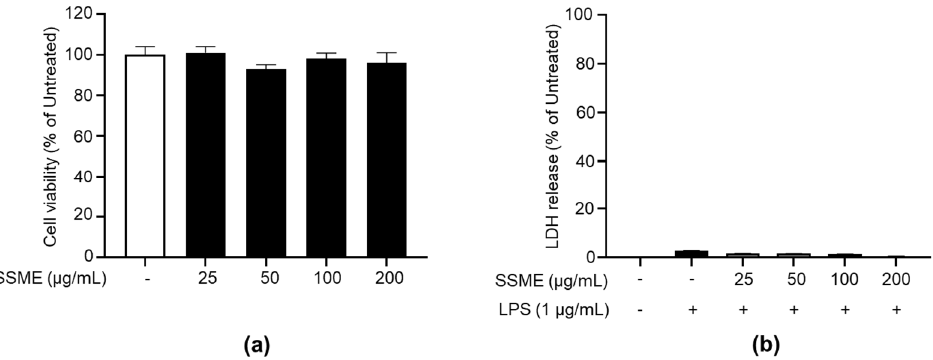
Figure 2. Effect of the SSME on the viability of the BV2 cells. ( a ) The BV2 cells were treated